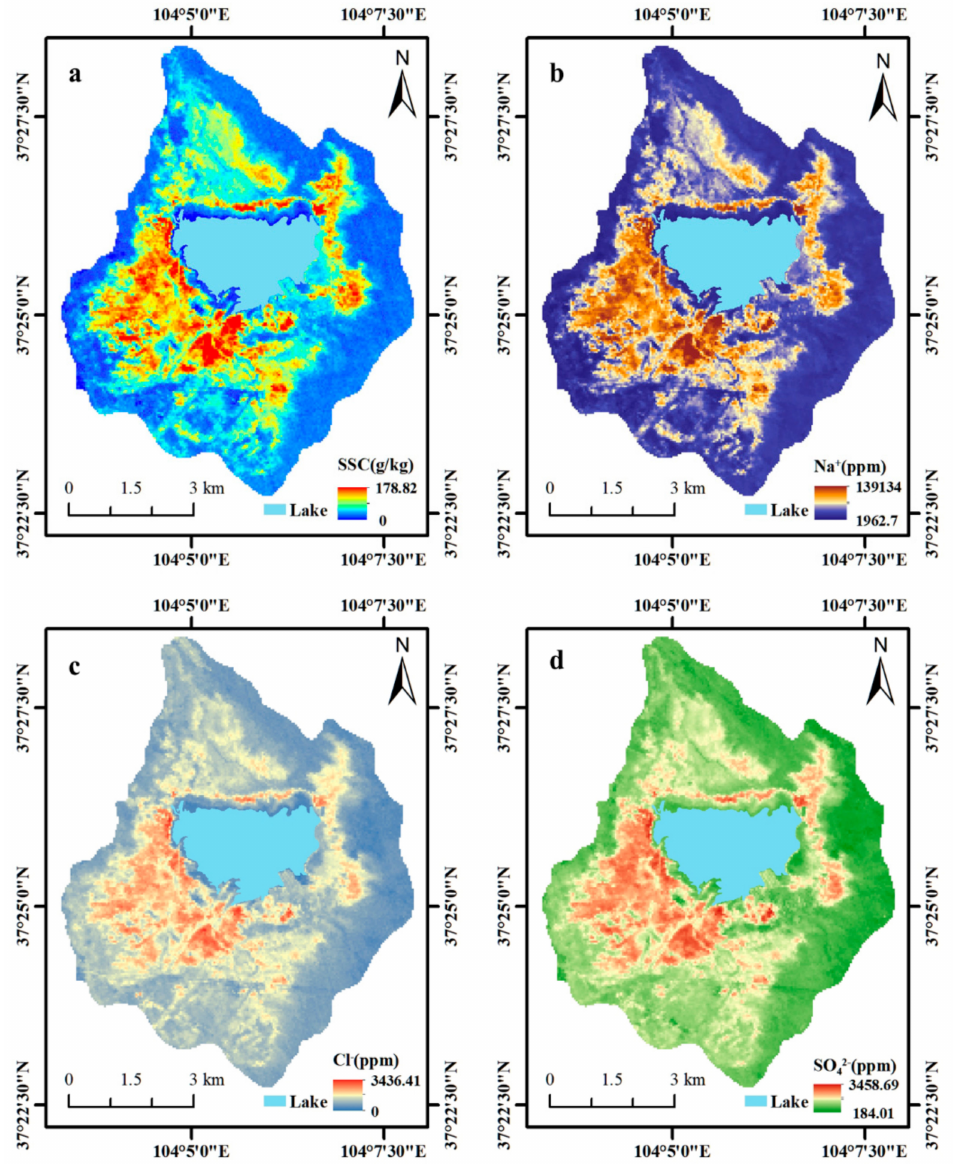
Figure 9. Estimation of the spatial distribution of the content of each soil component in the study area using the best available model. ( a ) Spatial distribution map of SSC in the study area; ( b ) spatial distribution map of Na + content in the study area; ( c ) spatial distribution map of Cl − content in the study area; ( d ) spatial distribution map of SO 42 − content in the study